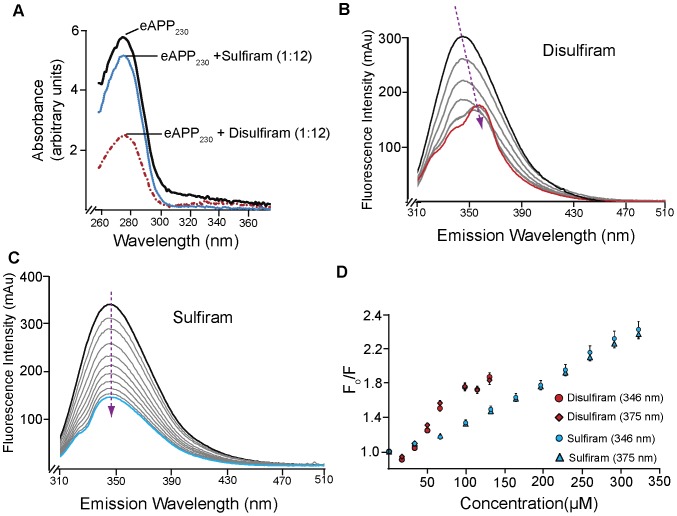
Disulfiram and Sulfiram bind to eAPP230–624.A) Difference absorption spectra of eAPP230–624 in the presence of sulfiram (blue) and disulfiram (dotted red) at a 1∶6 molar ratio. For each difference curve, the absorption spectra of PBS +2% DMSO, PBS plus 2% DMSO and 50 µM sulfiram or PBS plus 2% DMSO and 50 µM disulfiram were subtracted from the absorption spectra of 8.3 µM eAPP230–624 in the same buffer. B) Emission spectra from the titration of 0.64 µM eAPP230–624 with disulfiram from 0–130 µM (1∶0–1∶202 molar ratio) using the Shimadzu RF-530PC. The black line indicates the starting concentration and the red line indicates the final concentration. The arrow indicates the direction of shift of the fluorescence peak. C) Emission spectra from the titration of 0.64 µM eAPP230–624 with sulfiram from 0–320 µM (1∶0–1∶500 molar ratio) using the Shimadzu RF-530PC. The black line indicates the starting concentration and the blue line indicates the final concentration. The arrow indicates the direction of shift of the fluorescence peak. E) Stern-Volmer plot for the intermolecular quenching of 0.64 µM eAPP230–624 with either disulfiram (346 nm –red circles and 375 nm red diamonds) or sulfiram (346 nm–blue circles and 375 nm-blue diamonds).